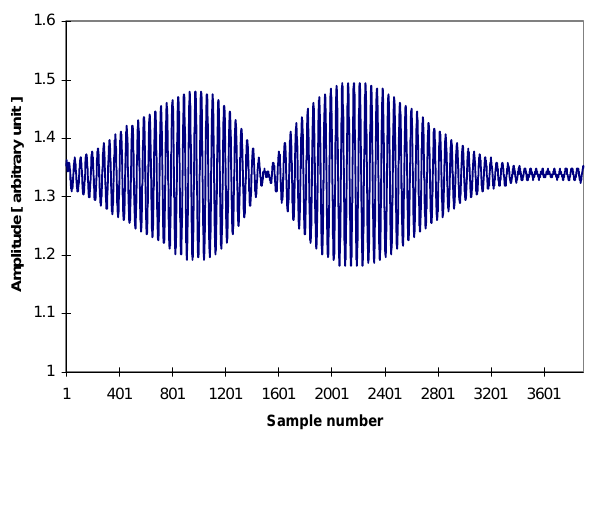
Figure 8 . Example of bi-modal fringe scan (Sensing